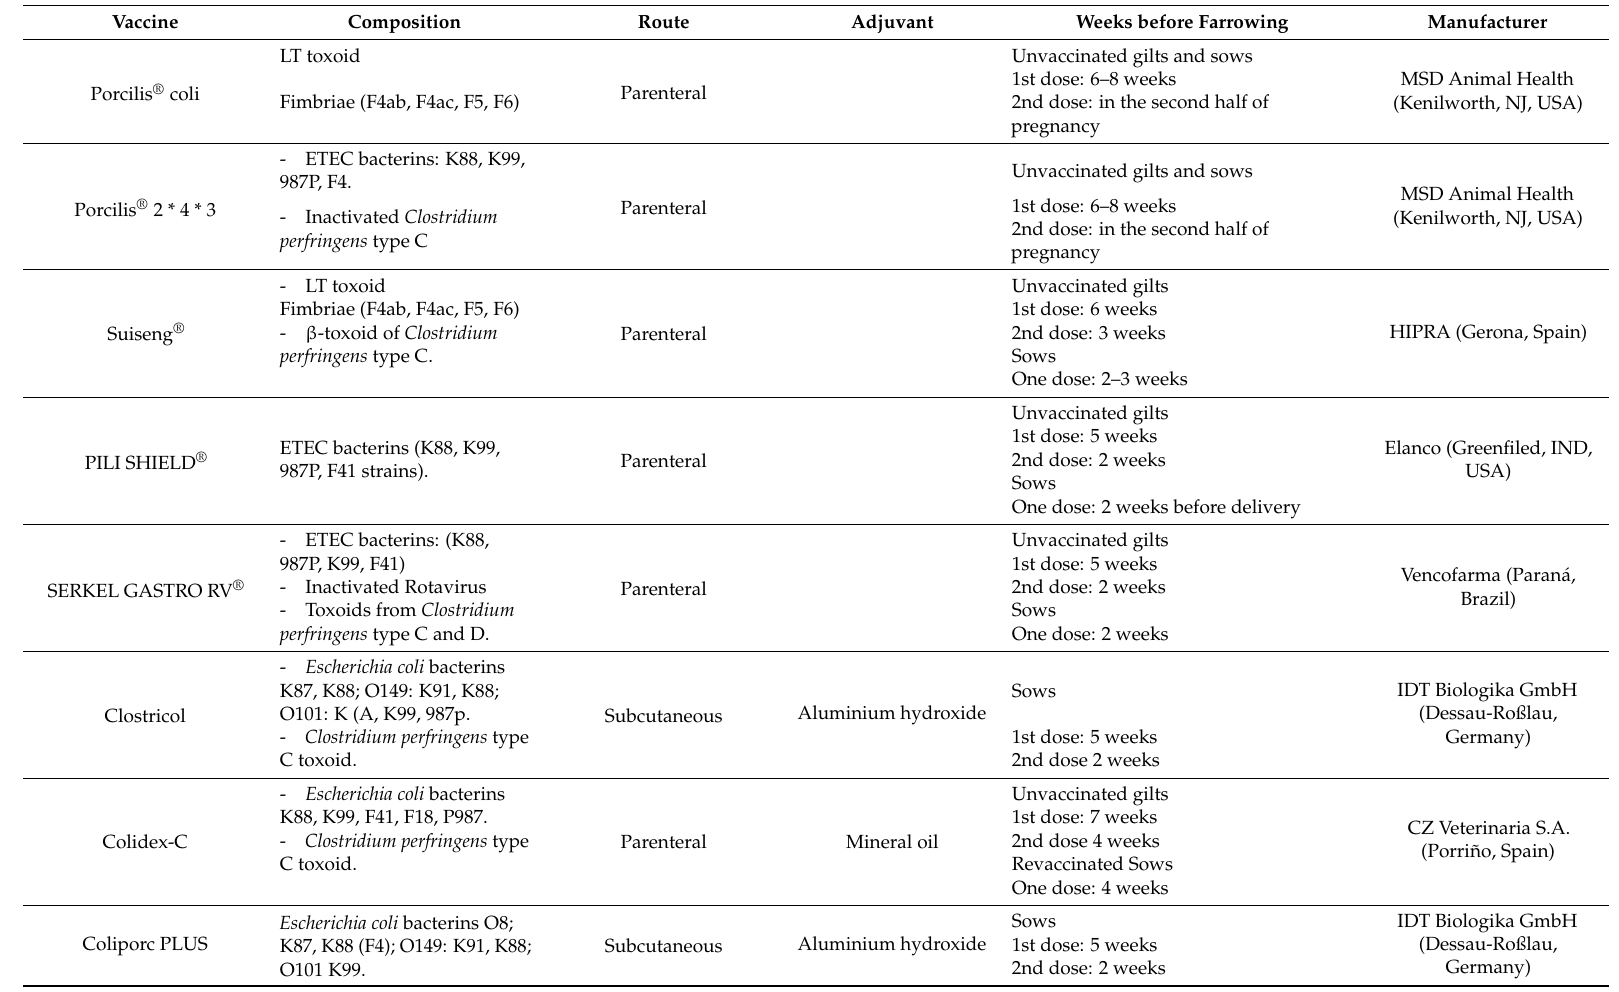
Table 1. Vaccines available for use in sows against